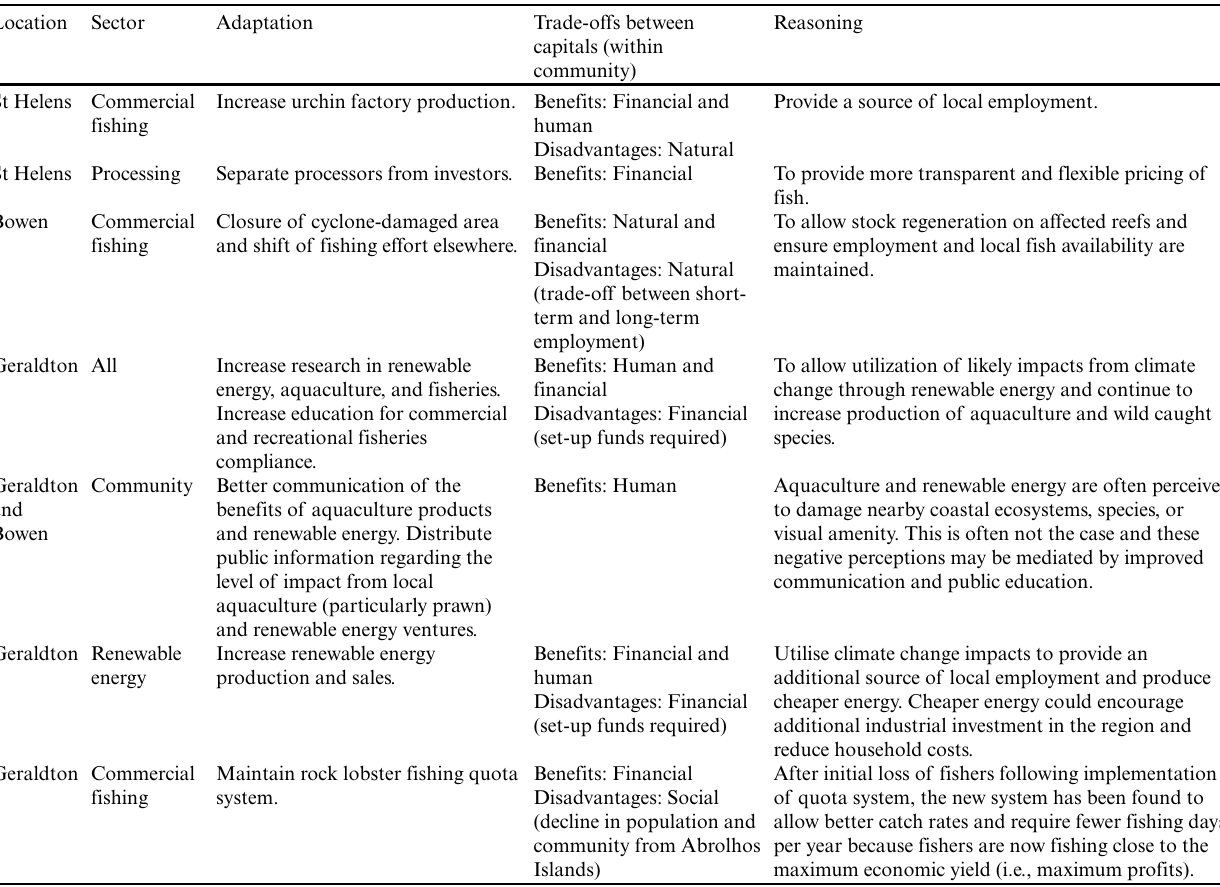
Table 9 . Unique community-based adaptations, reasoning, and trade-offs for the three case study communities. Location